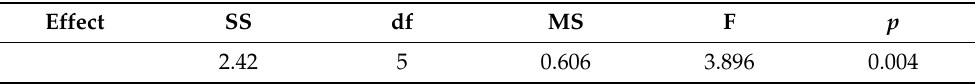
Table 3. Sums of square (SS), degrees of freedom (df), mean squares (MS), F-value, and p -level for overall goodness of fit through